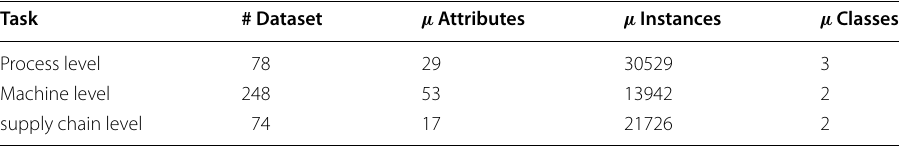
The “#” symbol denotes “number of”, and “ µ ” denotes “average of”